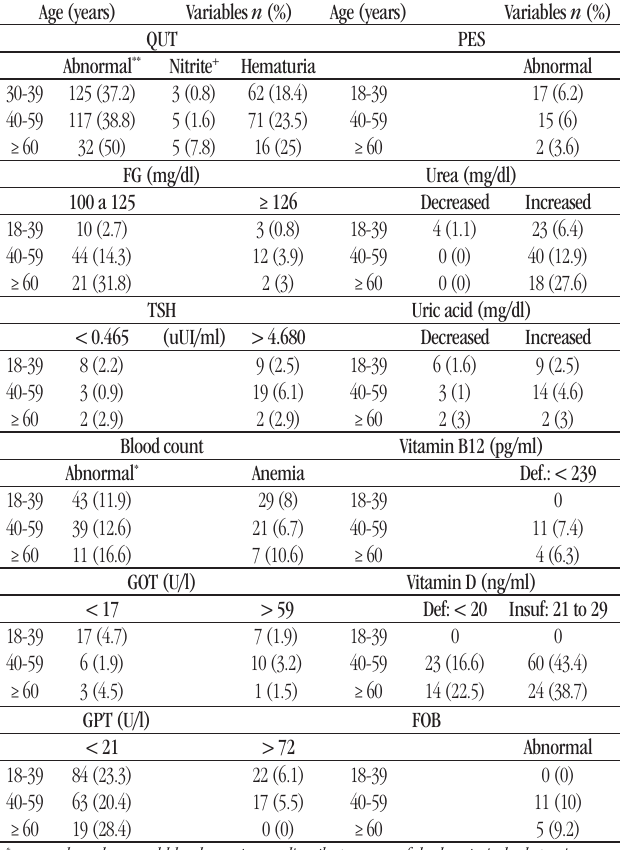
table 4 − Frequency of changes in laboratory tests in age groups